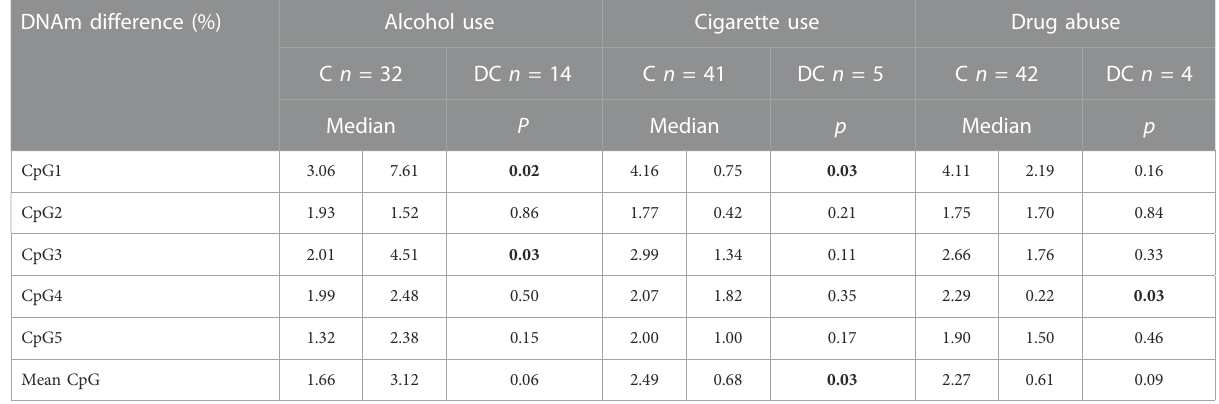
TABLE 5 Results of Mann-Whitney U-tests: Differences between concordant and discordant MZ twin pairs in risk behaviors. DNAm difference